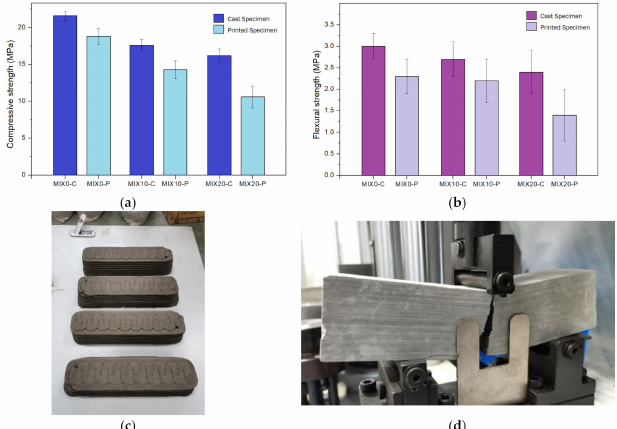
Figure 11. Compressive and flexural strengths of the cast and printed samples: ( a ) compres- sive strengths when loaded along the Z-axis, ( b ) flexural strengths when loaded along the Z-axis, ( c ) printed beams, and ( d ) three-point bending